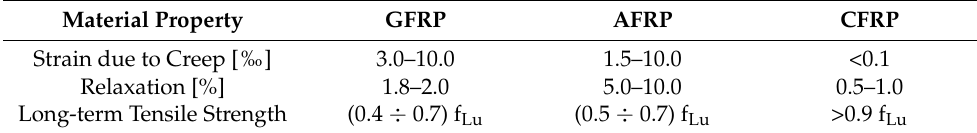
Table 2. The rheological properties of composite materials [26].